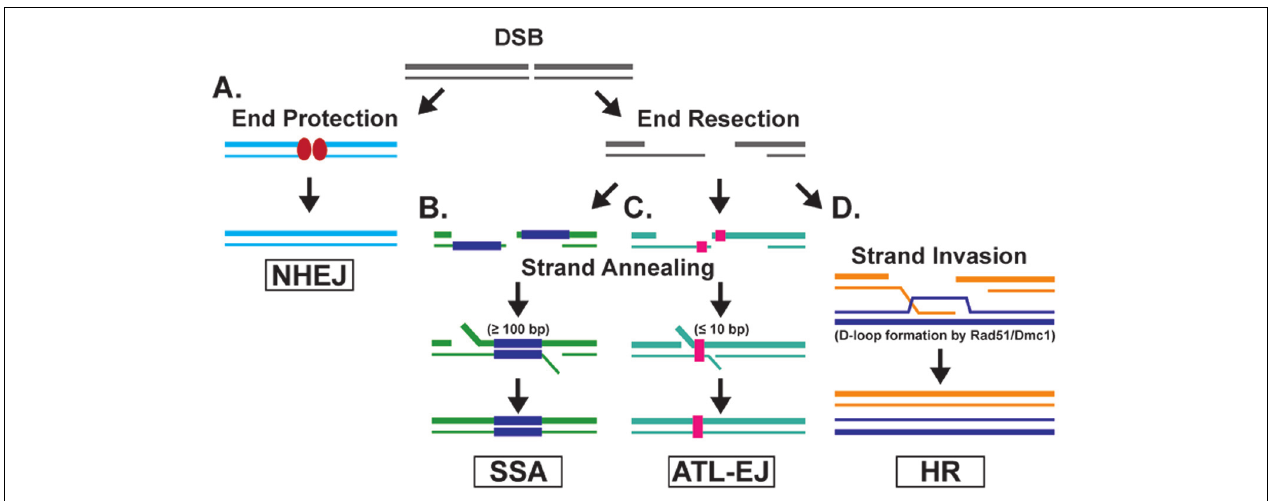
FIGURE 1 | Double-strand Break Repair Pathways. (A) The non-homologous end-joining (NHEJ) pathway is facilitated when the ends of the DSB are protected from resection and then ligated to mend the DSB. (B) Single-strand annealing (SSA) is a DSB repair pathway that anneals long stretches of homologous sequences flanking the DSB site. (C) The alternative end-joining (ALT-EJ) pathway anneals microhomologous sequences next to the DSB site. (D) In the homologous recombination (HR) repair pathway, a recombinase (Rad51 and/or Dmc1 in most eukaryotes) utilizes a homologous template (i.e., sister chromatid) to faithfully repair the